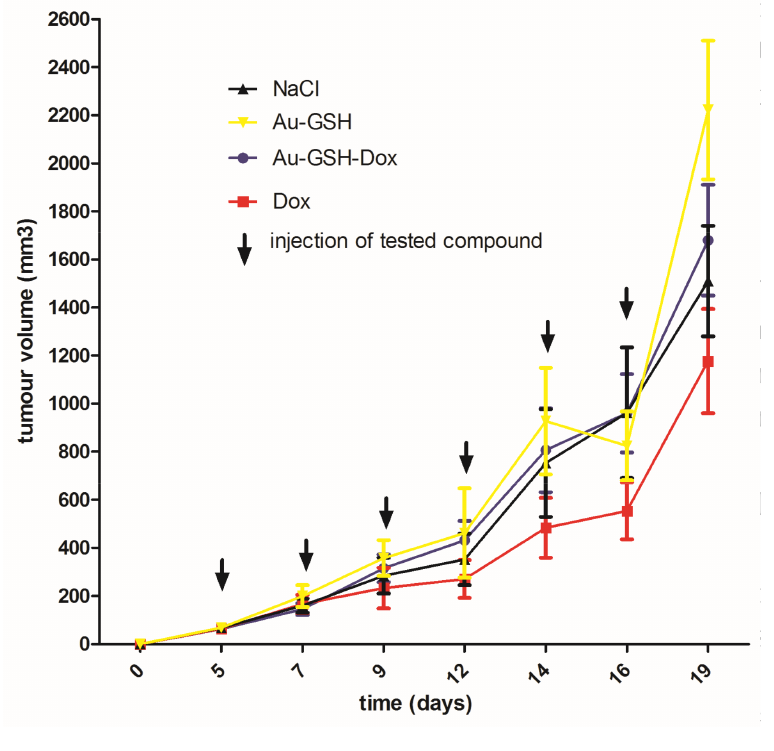
Figure 12. Tumor growth curve following treatment with tested compounds. Data are presented as the mean with SD.